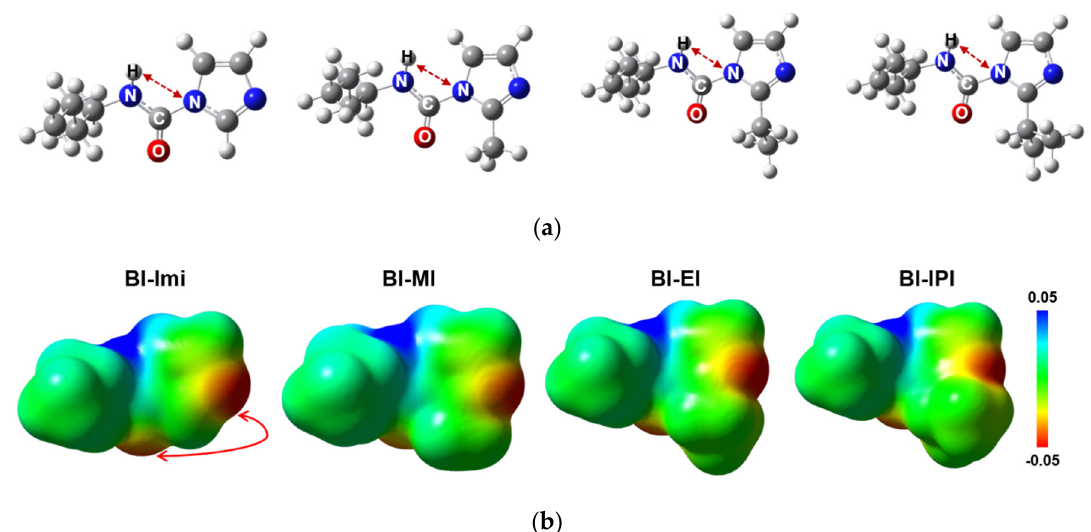
Figure 3. ( a ) Structural configurations and ( b ) electrostatic potential maps of blocked isocyanates- imidazole (BI-Imi), BI-2-methylimidazole (MI), BI-2-ethylimidazole (EI), and BI-2-isopropylimidazole (IPI). As the size of the alkyl group increases (from the left to the right), the H–N distance (red dash arrows in ( a )) decreases and the distance between O and N atoms (red solid arrows in ( b )) increases.